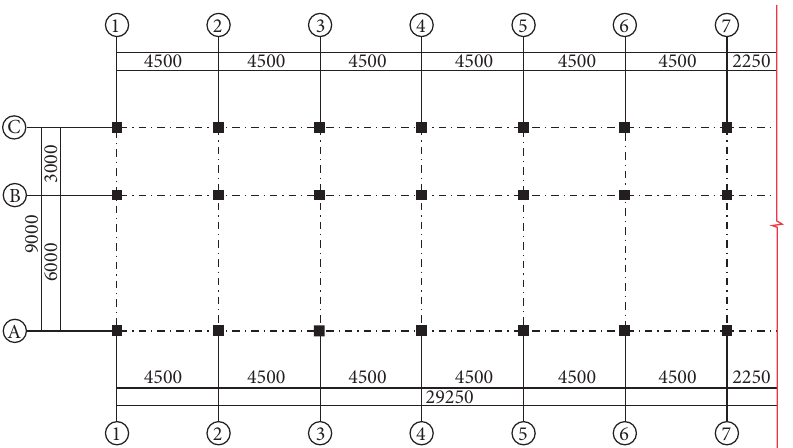
Figure 16: The column grid layout of Xuankou middle school teaching building (unit: